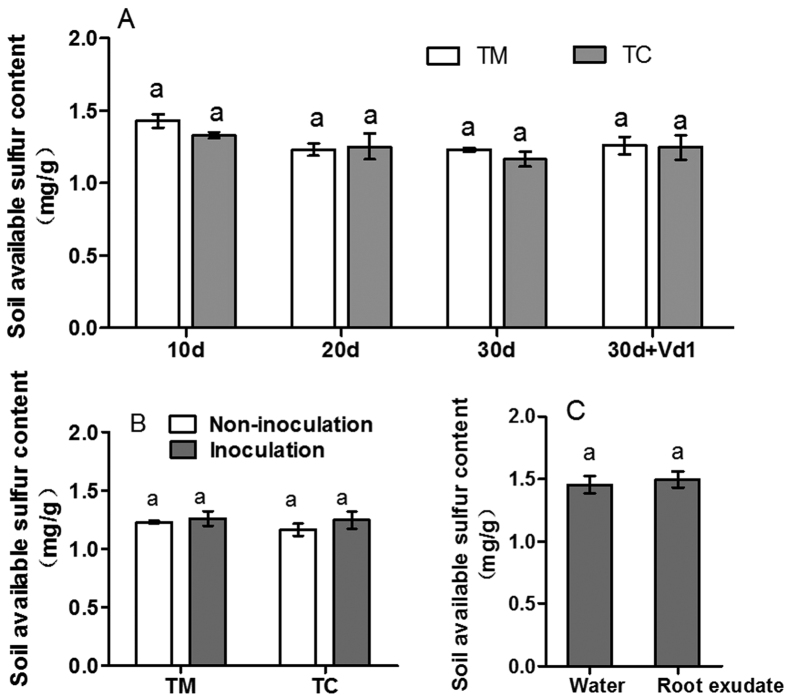
Effects of companion cropping with potato onion and potato onion root exudates on soil available sulfur content.(A) Effects of companion cropping with potato onion on the available sulfur content of tomato rhizosphere soil. (B) Effects of inoculation with V. dahliae on the available sulfur content of tomato rhizosphere soil. (C) Effects of potato onion root exudates on soil available sulfur content. The data are presented as the means ± SD, n = 3. The small letter “a” above the column represents no significance between the two groups of mean values (p > 0.05).